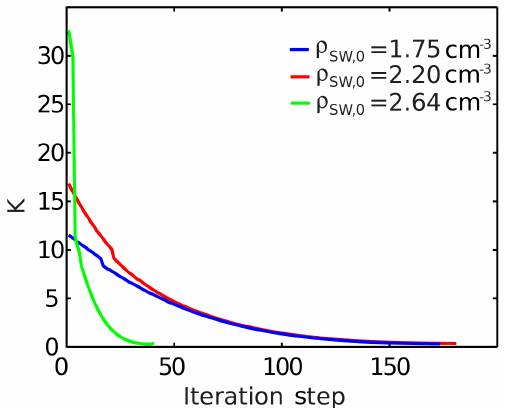
Figure 5. The value of the cost function at each iteration step is shown for three different initial densities. Independent of the start- ing value, the cost function converges to the identical value.